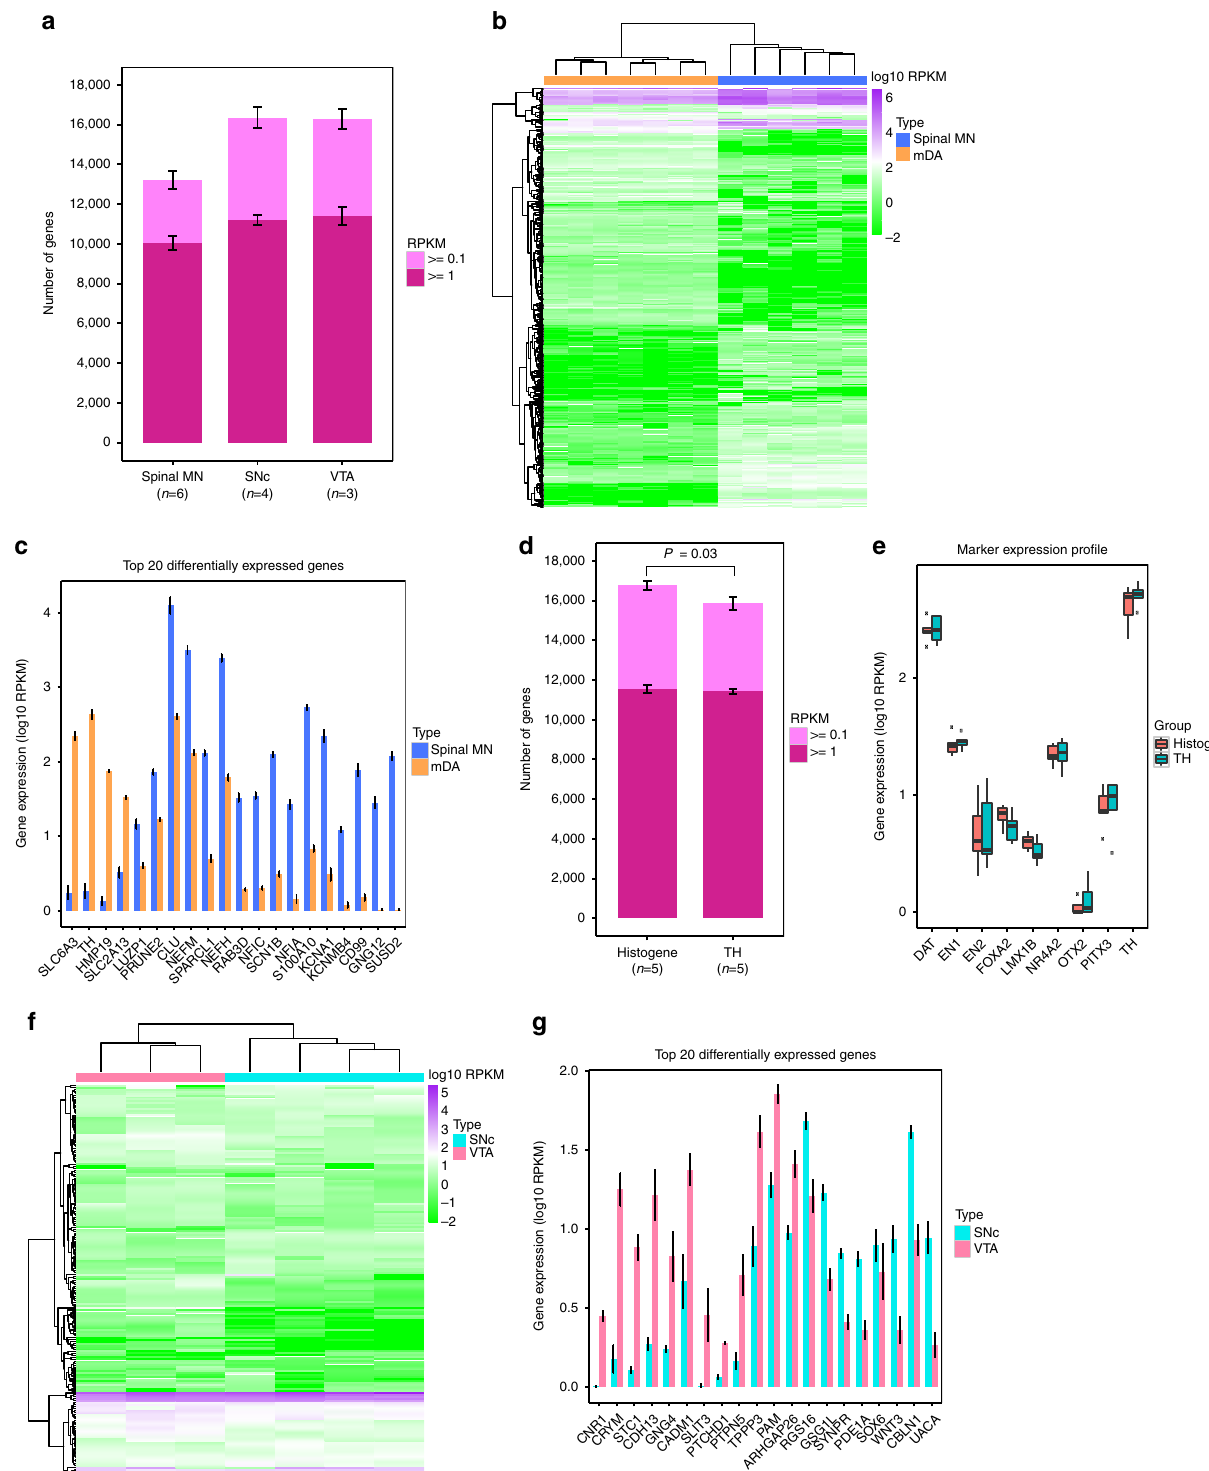
Figure 4 | LCM-seq is applicable to partly degraded human post-mortem tissues and reveals differential gene expression of spinal MNs and mDA neurons. ( a ) Mean number of genes detected in MNs ( n ¼ 6) and mDA neurons (SNc: n ¼ 4; VTA: n ¼ 3, mean ± s.e.m.). ( b ) Clustering of MNs ( n ¼ 6) and mDA neurons ( n ¼ 7) based on the top 500 variable genes in expression. ( c ) Top 20 differentially expressed genes between spinal MNs and mDA neurons (adjusted P o 0.05, Wald test, DESeq2, sorted by fold change and adjusted P , mean ± s.e.m.). ( d ) A larger number of genes was detected in mDA neurons using Histogene staining than the quick TH antibody staining ( P ¼ 0.03, Student’s t -test at 0.1 RPKM cutoff, mean ± s.e.m.). ( e ) Comparable mDA neuron marker expression levels were detected between the Histogene and quick TH staining groups. Boxes range from the 25th to the 75th percentile, with the centerline representing the 50th percentile. Outliers are shown as dots. ( f ) Clustering of SNc ( n ¼ 4) and VTA ( n ¼ 3) neurons, using Histogene staining, based on the top 500 variable genes in expression. ( g ) The top 20 differentially expressed genes between SNc and VTA neurons (adjusted P o 0.05, Wald test, DESeq2, sorted by adjusted P , mean ±